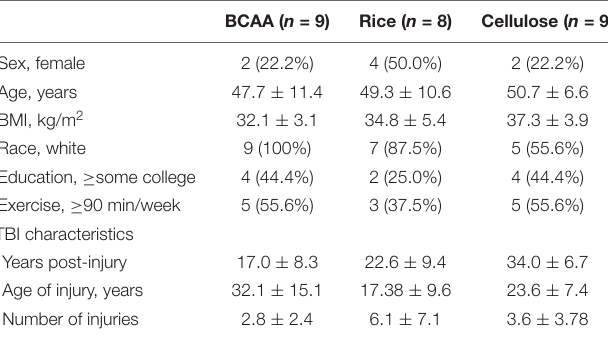
TABLE 1 | Demographic information across all